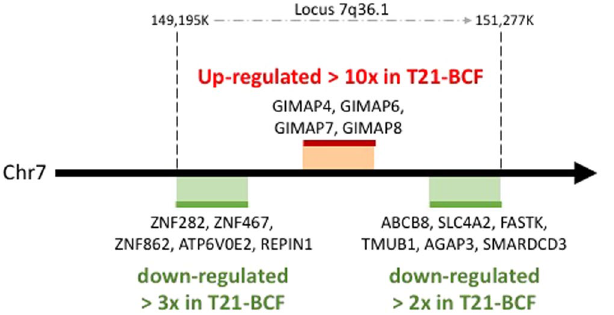
Figure 3. Physical map of 7q36.1 locus with groups of co-regulated genes in differential analysis between T21- BCF compared to the T21-BC or C-BC